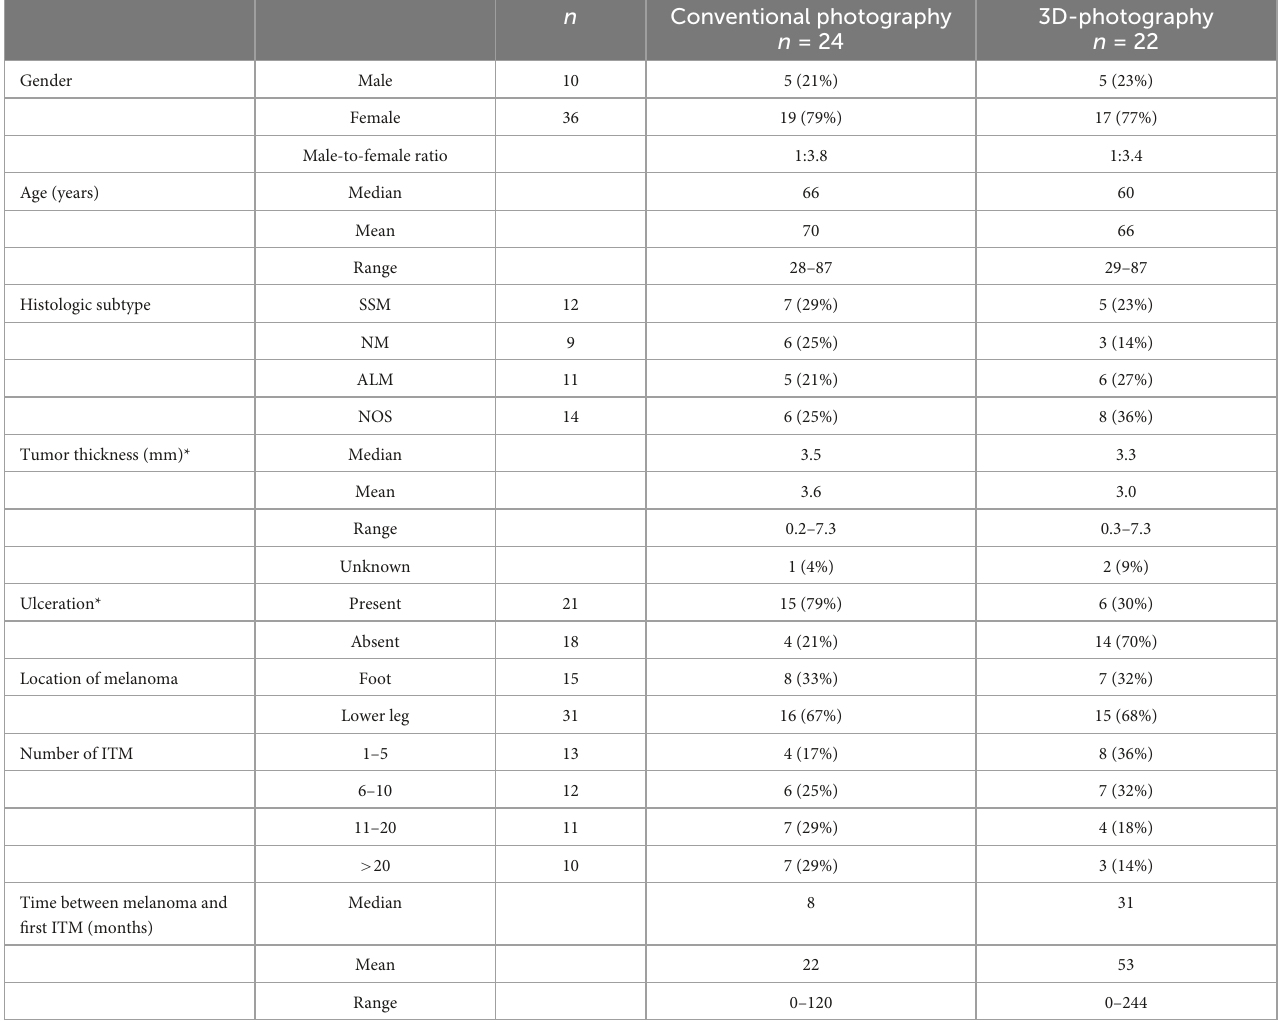
TABLE 3 Patients with melanoma of the lower leg and foot with analyzed in-transit metastases patterns.